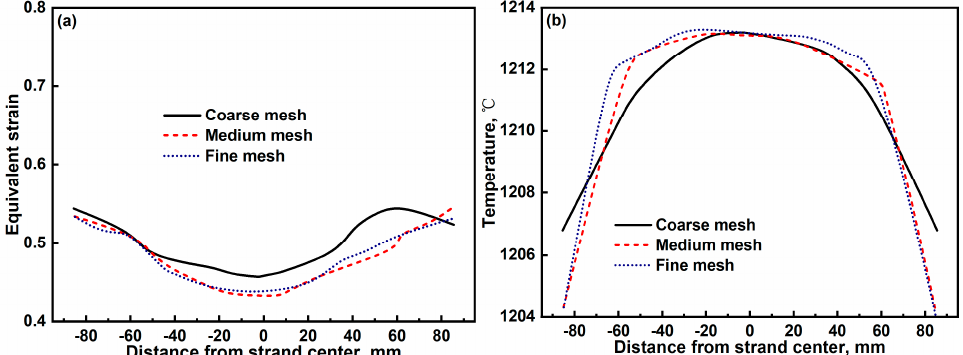
Figure 5. The variations in equivalent stains ( a ) and temperatures ( b ) along the thickness direction of the intermediate slab after R1 pass at three mesh levels.